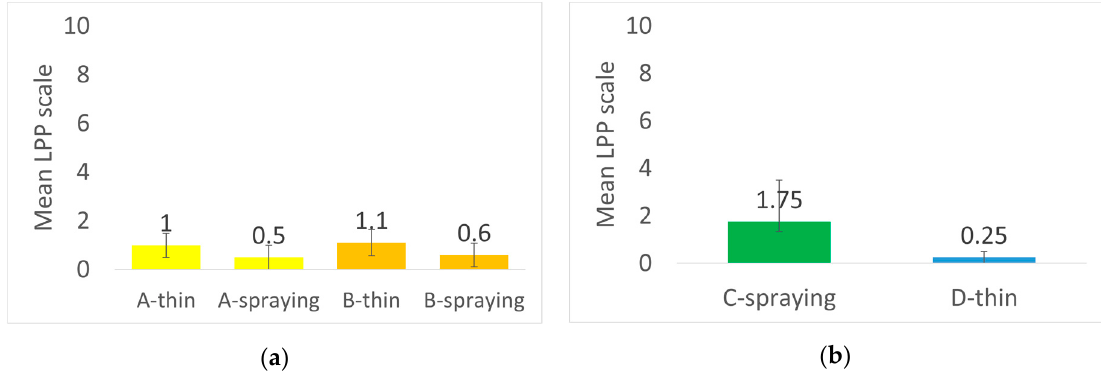
Figure 7. Mean LPP scale of the upper limb using the PULE for: ( a ) fruit thinning and pesticide spraying simulations for groups A and B; ( b ) fruit thinning of the jujube tree and pesticide spraying of the pomelo tree for groups C and D.